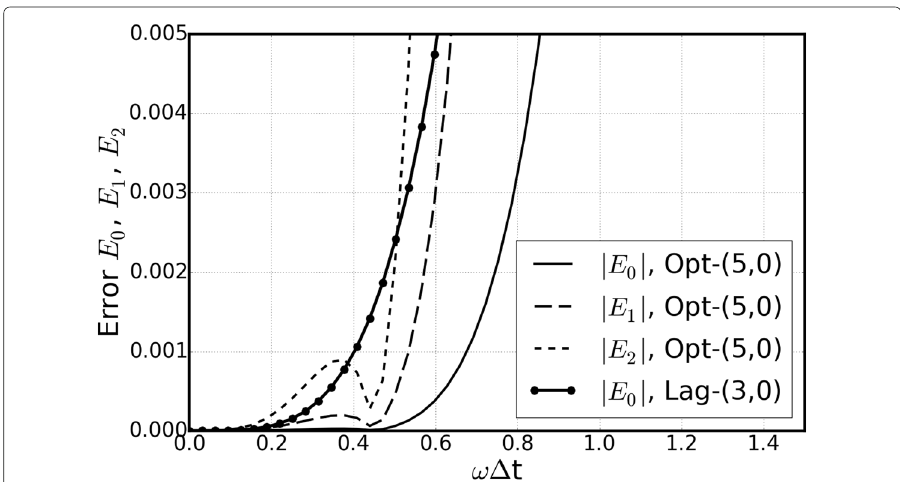
Fig. 4 Maximum of error functions E 0 (η , ξ) , E 1 (η , ξ) and E 2 (η , ξ) for the optimized Opt-(5,0) scheme. Also shown is the error function E 0 for the Lag-(3,0)